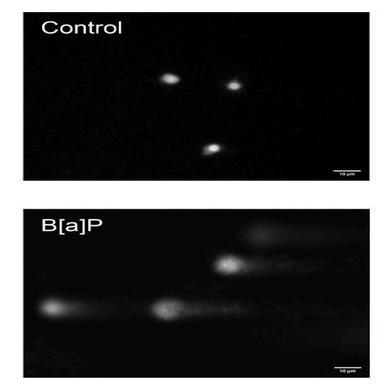
Genotoxicity assessment. The comet assay was applied to single-cell suspensions prepared from zebrafish embryos after 24 h of exposure to MXenes (80 mg/ L), BP (1 mg/L), and NOM (10 mg/L). Data are presented as mean values ± S.D. of three independent experiments (with a minimum of 100 cells per sample). Oneway ANOVA with Tukey's multiple comparison test was used to analyze statistical differences between the exposures (p < 0.05, p < 0.01, p < 0.001, p < 0.0001). (B) Representative images wherein the absence